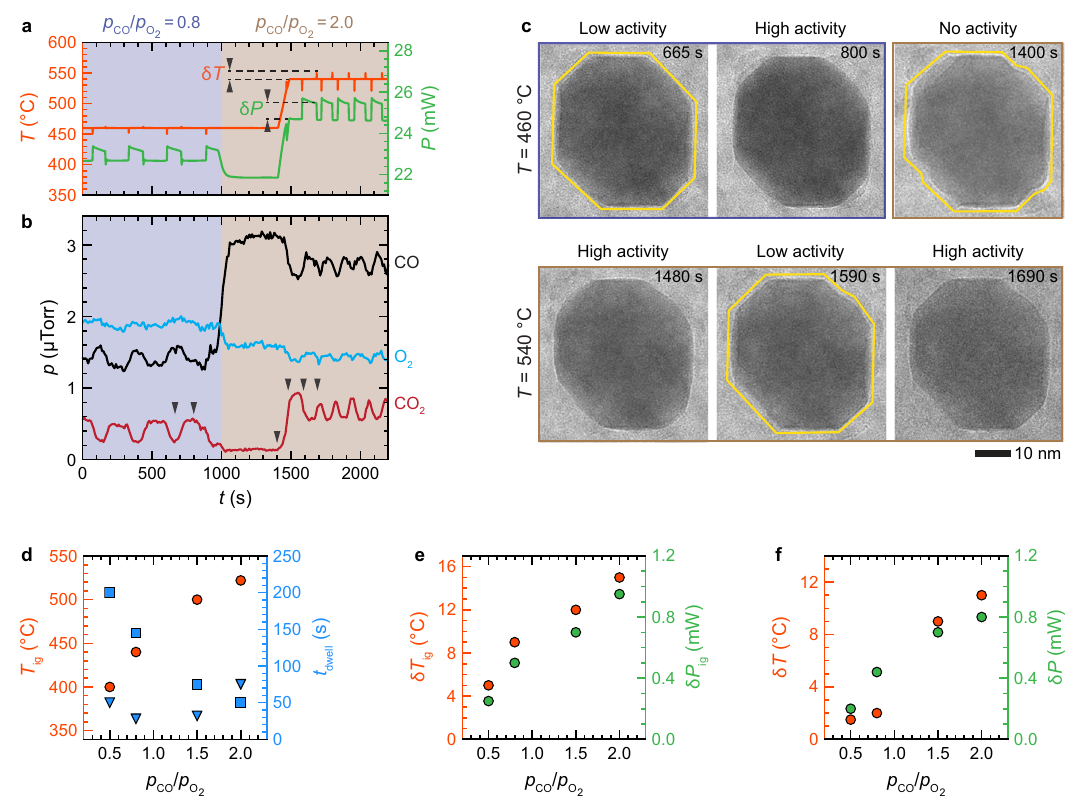
Fig. 4 | Impact of CO pressure ( p co ) on the oscillatory reaction over truncated increased to 540°C at t ≥ 1590s (Supplementary Movie 4). d The ignition tem- Pd nanocube. a Plots of the measured temperature, heater power, and b the peratures for the conversion reaction ( T ig , orange circles) as a function of and the corresponding dwell time of catalyst in low-activity (blue trian- corresponding amounts of the CO, O 2 , and CO 2 gases during the CO oxidation p CO = p O 2 ≈ 0 : 8andat540°Cand p = p ≈ 2 : 0.Thearrowsin reactionat460°Cand p CO = p O gles)andhigh-activity(bluesquares)states. e Ignition-inducedtemperaturejump CO O 2 2 b correspond to the timepoints of the image series shown in c . c In situ TEM ( δ T ig ,orangecircles)andconcurrentdropinheaterpower( δ P ig ,greencircles),as indicated by arrows in Supplementary Fig. 20d as a function of the gas ratio image series of a truncated nanocube showing a periodic restructuring corre- ≈ 0.8 (Supplementary ( p CO = p O sponding to the oscillations during t =0 – 1000s at p CO = p O ). f Thejump in temperature ( δ T , orange circles)and concurrent drop in 2 2 Movie 3). At t =1000 – 1400s, when the partial pressure was increased to heater power ( δ P , green circles) as a function of the gas ratio ( p CO = p O ≈ 2 : 0, while maintaining the temperature at 460°C, the corner of the onset of high-activity states of the oscillatory reaction, as described in a . The p CO = p O 2 nanocube became fl at, and the activity dropped almost to 0. The oscillation results shown in d – f are extracted from the measurements shown in Supple- ≈ 2 : 0) when the temperature was resumed under this CO-rich condition ( p CO = p O mentary Fig. 2